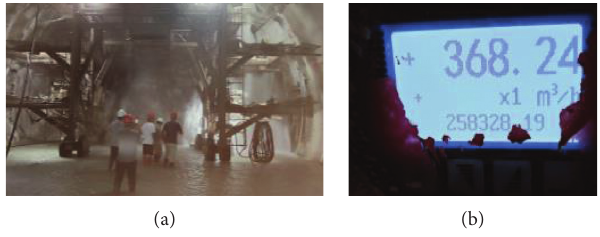
Figure 12: Drainage and flow monitoring.